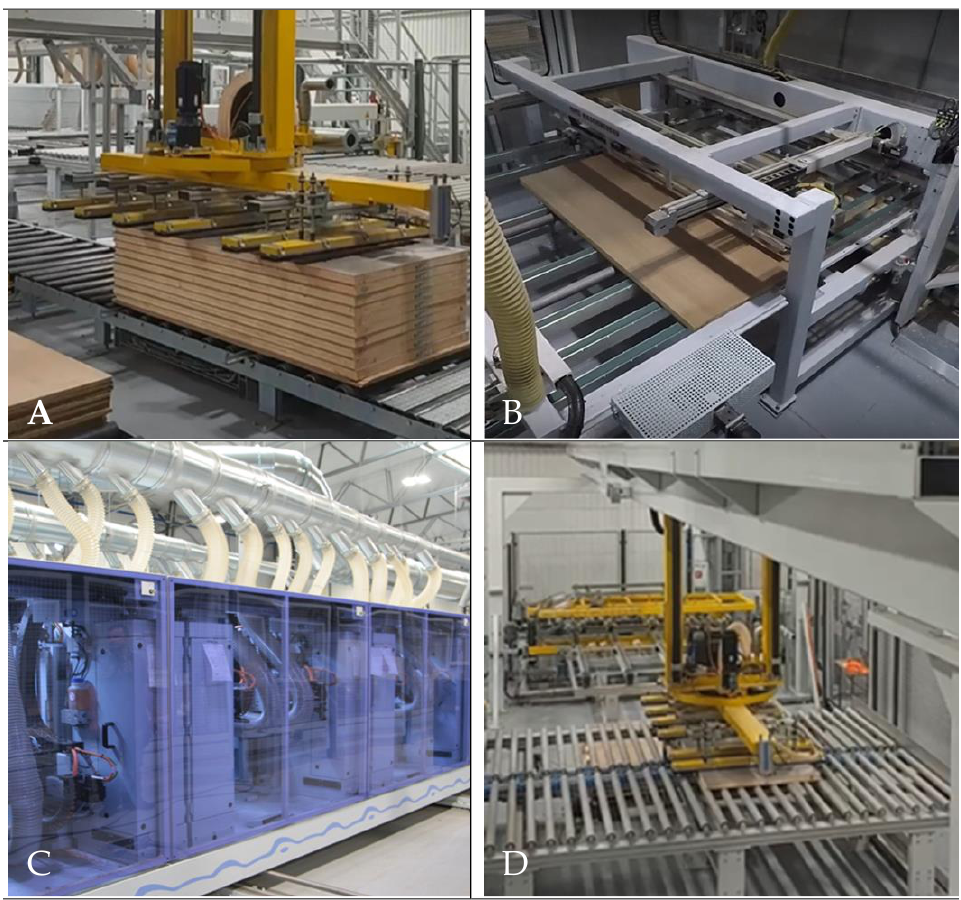
Figure 1. The arrangement diagram and the most important machine units of the edge banding module.